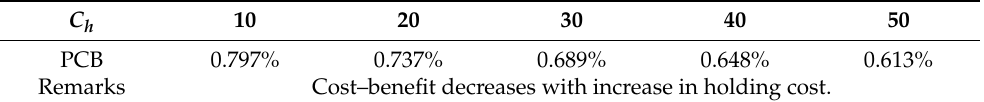
Table 6. Sensitivity of “holding cost” to cost–benefit. The static input values of the parameters are: